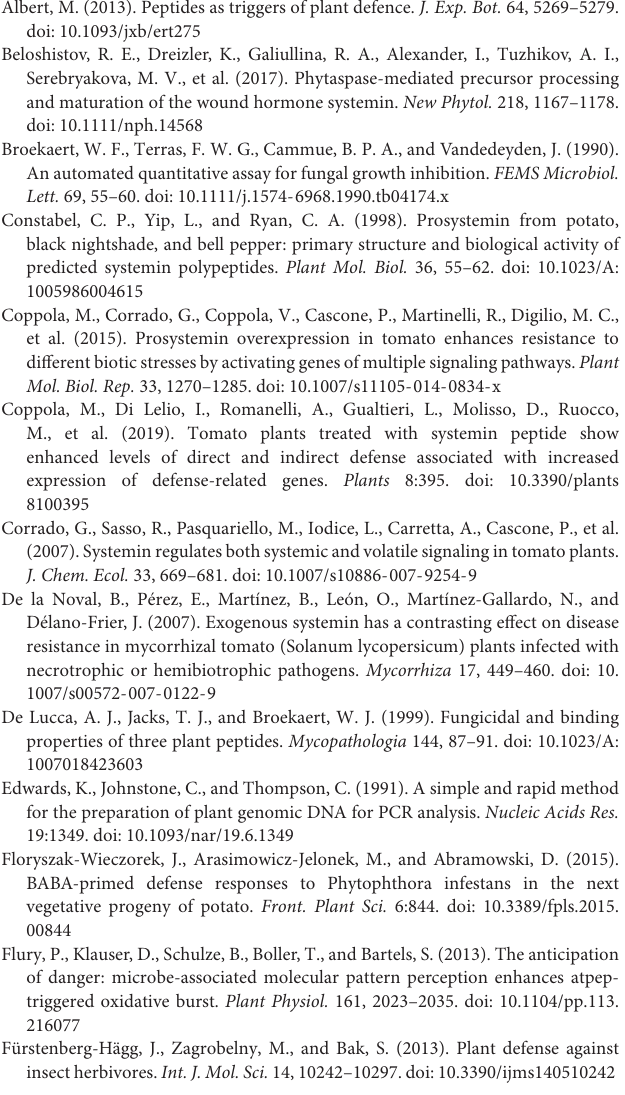
was expressed in Relative Luminescence Units. Bars represent means of peak areas ± standard error (SD), n = 8. Different letters represent statistically significant differences. (ANOVA, Fisher’s Least Significant Difference (LSD) test; P < 0.05, n = 8). FIGURE S9 | Sys-IR assays in the pepr1 mutant. Col-0 and pepr1 plants were challenged with 1 µ l droplets of 5 × 10E3 spores/ml of P. cucumerina BMM 24 h after treatment with 0.1 nM Systemin. Infection levels were quantified 5 days after inoculation by a disease rating in trypan blue stained leaves, measured as a percentage of the infected leaf surface. Colors mean % of diseased leaves in a scale (0 = healthy leaves; 1 = leaves with less than 25% of diseased surface; 2 = leaves with 25–50%; 3 = leaves with 50–75% of the diseased surface, 4 = leaves with more than 75% of the surface diseased). Asterisks mean statistical significant differences; T -test; P < 0.05, n = 12). The experiment had 12 plants per treatment and was repeated at least three times with similar